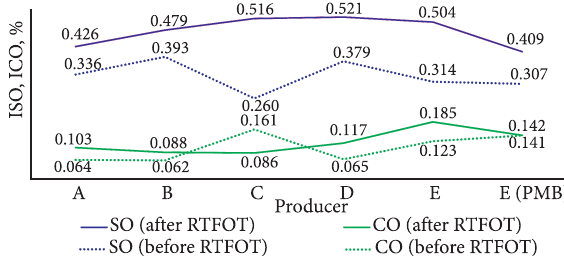
fig. 6. Comparison of sulfoxide and carbonyl in bitumen from different producers before and after short-term aging